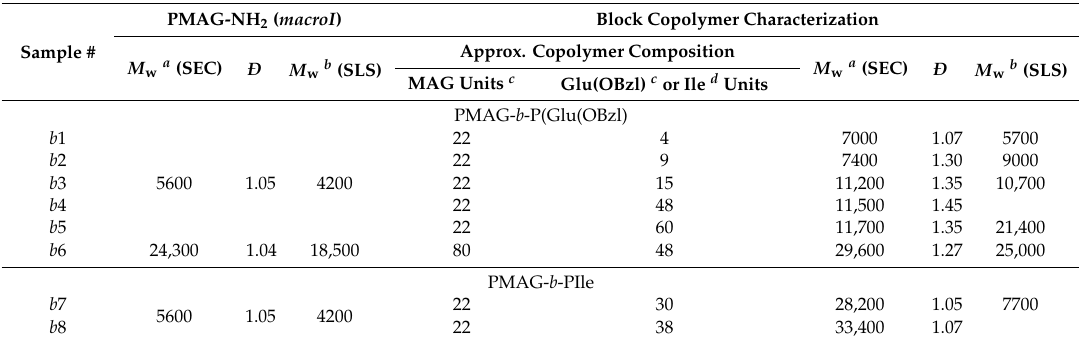
Table 3. The characteristics of synthesized amphiphilic hybrid copolymers.